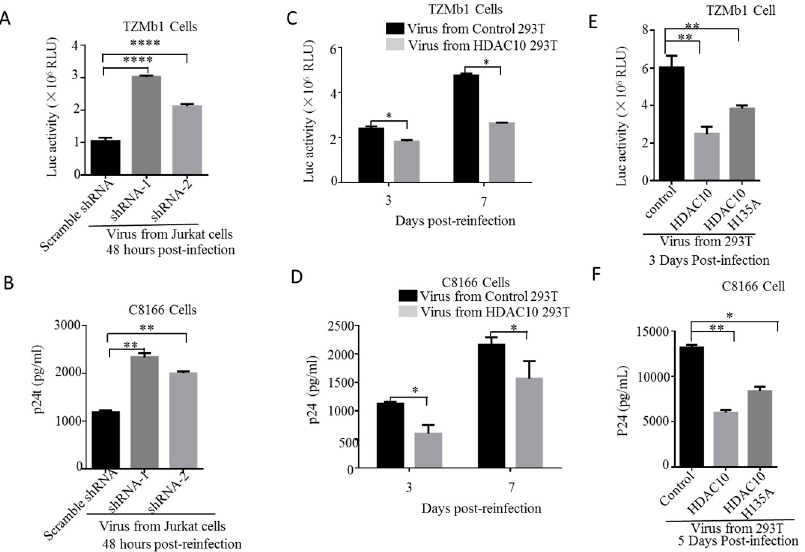
Figure 6. The infectivity of virus produced from HDAC10-KD or HDAC10 overexpressed cells. ( A , B ). The progeny virus was produced from HDAC10-KD Jurkat cells are used to infect TZMb1 and C8166 cells. The infectivity of virus was detected by measuring luciferase activity in TZMb1 cells ( A ) or p24 production in the supernatant from C8166 cells ( B ). ( C , D ) The progeny virus was produced from HIV-1 PNL4.3 provirus and HDAC10, or HIV-1 PNL4.3 provirus and GFP (control) co-transfected 293T cells. The same amount of progeny virus was used to infect TZMb1 or C8166 cells and the infection of the virus was detected by measuring luciferase activity in TZMb1 cells ( C ) or p24 in the supernatant from C8166 cells ( D ). ( E , F ) The infectivity of progeny viruses produced from PNL4.3 / HDAC10, PNL4.3 / HDAC10 H135A, or PNL4.3 / GFP overexpressed cells. The viruses were produced from HIV-1 PNL4.3 / HDAC10, PNL4.3 / HDAC10H135A, or PNL4.3 / GFP co-transfected 293T cells. The same amount of progeny virus was used to infect TZMb1 or C8166 cells and the infectivity of the virus was detected as described above. The values presented are the means and standard deviations from two independent experiments. *, p < 0.05; **, p < 0.01; ****, p < 0.001. (Two-tailed unpaired t -test).